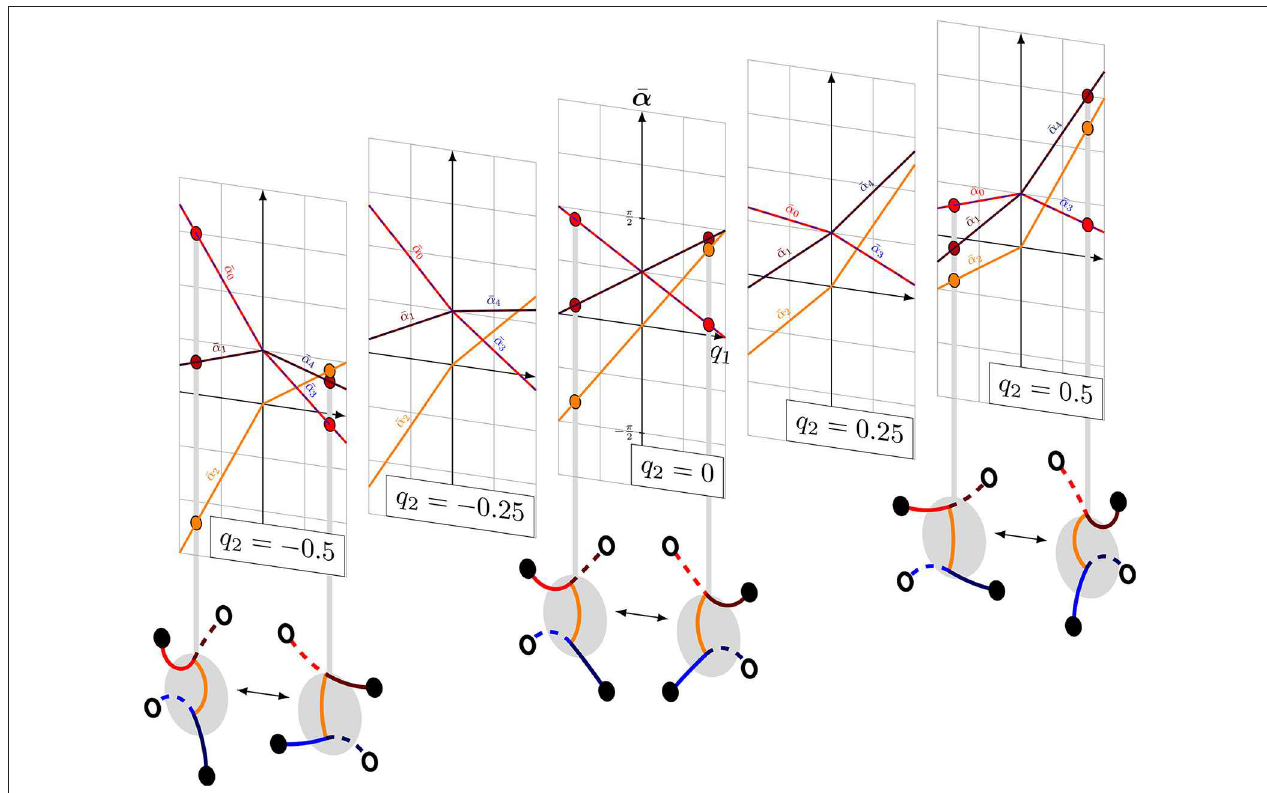
FIGURE 5 | Visualization of the velocity space defined the by general gait law from Equation (14) for q 2 ∈ {− 0.5, − 0.25,0,0.25,0.5 }